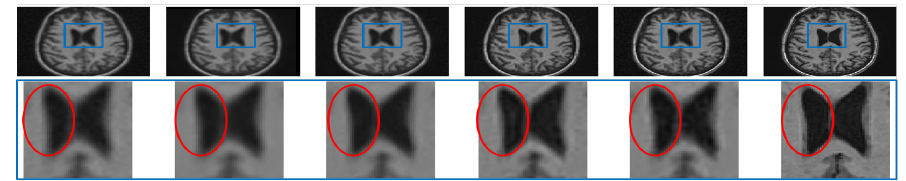
Figure 15. Illustration of super resolving the real MR images of an Alzheimer’s subject degraded with downsampling factor 2 and 2% noise. From Left: Interpolated noisy LR image, spline interpolation of denoised image, NLM3D-based super-resolved denoised image, LRTV-based super resolution of the denoised image, the proposed approach super resolving the noisy LR image, and the original noiseless HR